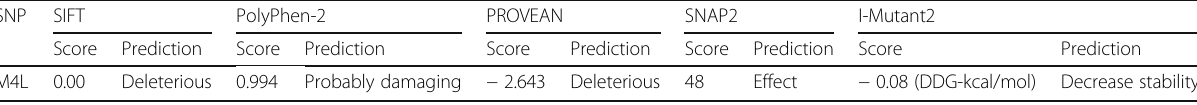
Table 4 The in silico analysis of the observed nonsynonymous SNPs in BMP15 using several bioinformatics tools SNP SIFT PolyPhen-2 PROVEAN SNAP2 I-Mutant2 Score Prediction Score Prediction Score Prediction Score Prediction Score